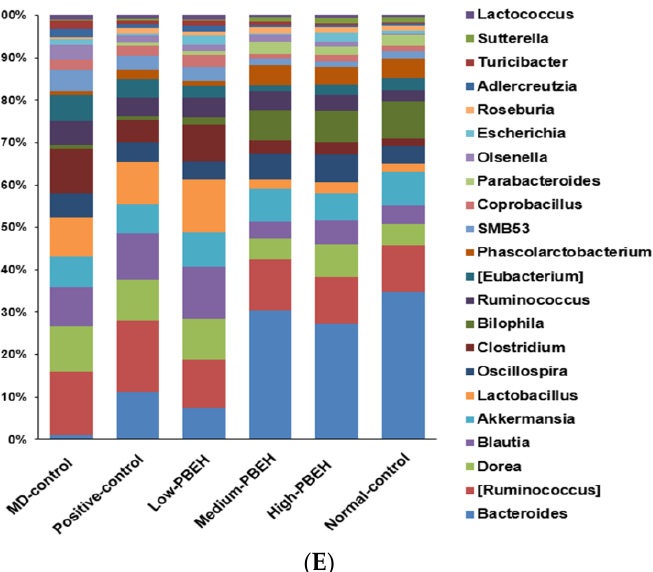
Figure 4. Gut microbiota α - and β -diversity and profiles. Male rats had intraperitoneal injections of scopolamine (2 mg/kg body weight/day) at 30 min after daily feeding of casein (MD-control), porcine brain enzyme hydrolysates (PBEH; 7 mg total nitrogen/mL) at 0.053 mL (Low-PBEH), 0.159 mL (Medium-PBEH), 0.478 mL (High-PBEH), or 10 mg donepezil (Positive-control) per kilogram body weight per day for six weeks. ( A ) Chao1 index of fecal bacteria; ( B ) Shannon index of fecal bacteria; ( C ) principal coordinate analysis (PCoA) of fecal bacteria; ( D ) relative amounts (%) of fecal samples at the family level; ( E ) relative amounts (%) of fecal samples at the genus level. Bars and error bars represent the means ± standard deviations ( n = 10). a,b,c Different superscript letters on the bars indicated a significant difference among the groups by Tukey test at p < 0.05.